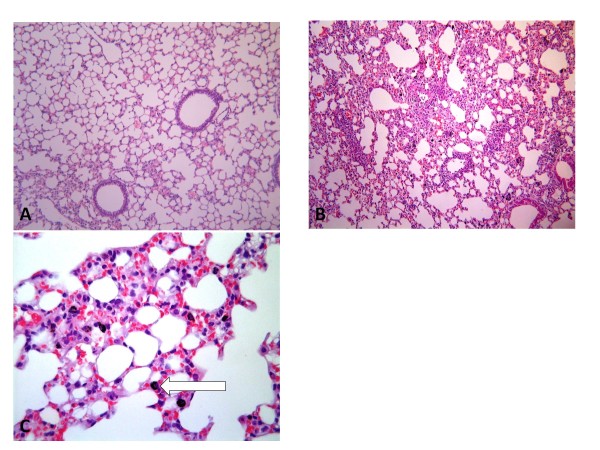
A,B,C; Lung histology of uninfected mice exposed to; A) intranasal PBS and B) 2× doses of 500 μg ultrafine-carbon black (UF-CB). Sections were imaged under light microscopy (200×). Figure C) shows lung tissue of an UF-CB exposed animal under higher power (400×). Changes induced by UF-CB are given in Table 1. The most distinctive feature is carbon-laden alveolar macrophages (arrow). There is no evidence of free carbon in the airway, or significant uptake of carbon by other airway cells.